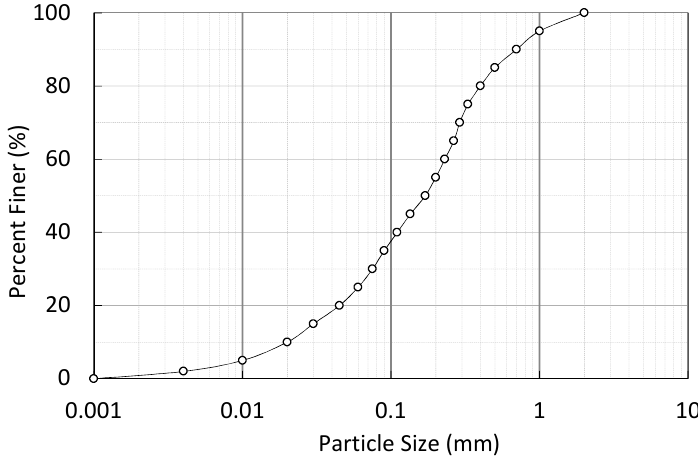
Figure 4. Grain size distribution curve of the copper tailings sample. Table 2. Properties of the copper tailings sample.